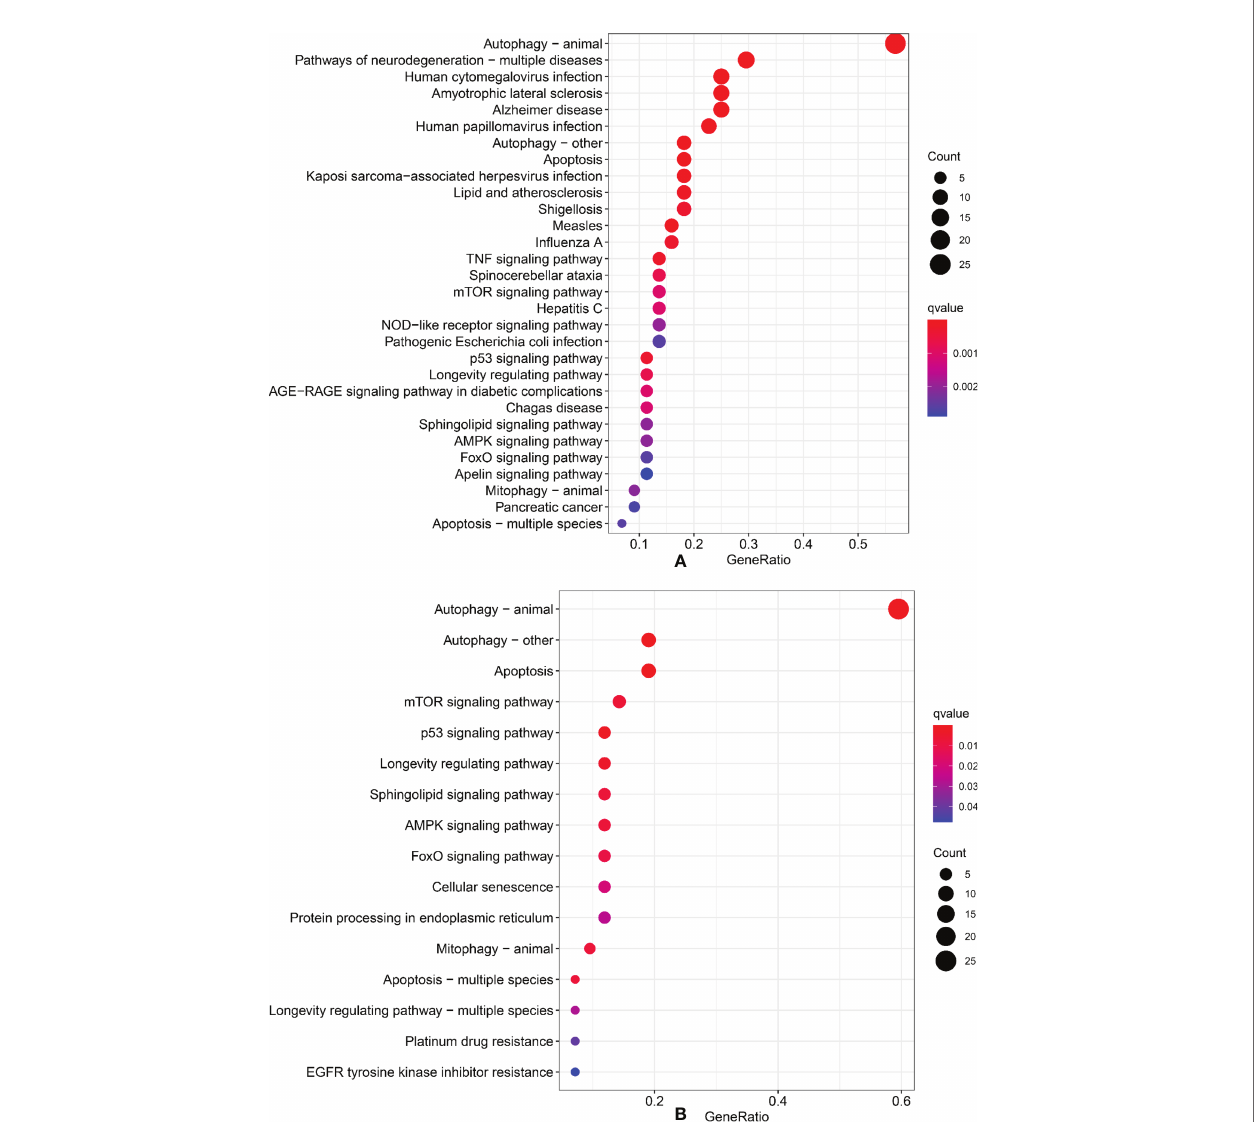
FIGURE 7 | Gene Ontology and Kyoto Encyclopedia of Genes and Genomes. (A) GO analysis. (B) KEGG